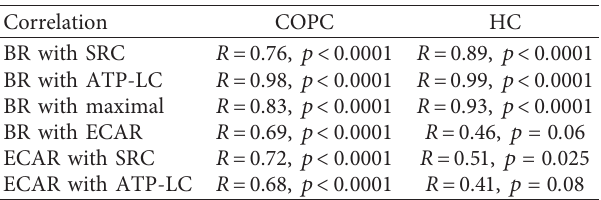
Figure 2: Oxygen consumption rate in non-mitochondrial respiration, basal respiration rate, ATP production (ATP-LC), and extracellular acidification rate (ECAR) in healthy controls and COPC. Table 2: Correlation across bioenergetic variables in COPC and